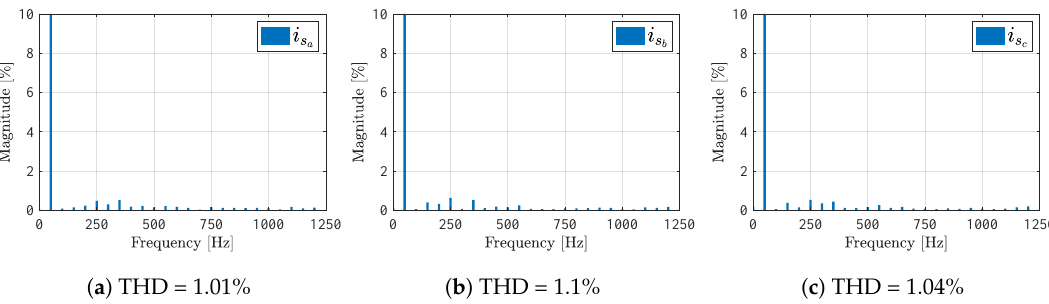
Figure 6. Frequency spectrum of the output phase currents in % with respect to the 50 Hz fundamental current